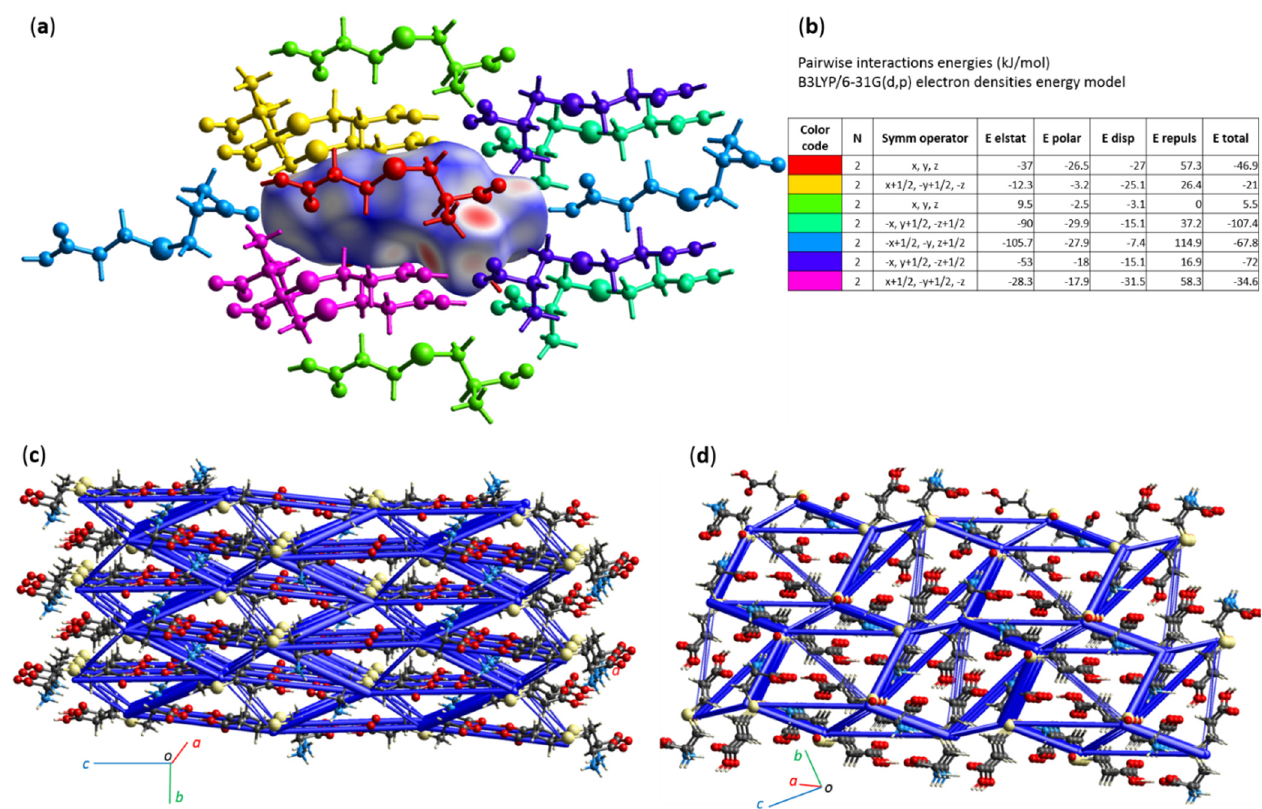
Figure 3. Interaction energies in crystal structures. ( a ) A view of interactions between a central molecule of β -CEC in crystalline 1 , shown as its Hirshfeld surface, and 14 molecules that share the interaction surfaces with the central molecule. ( b ) Calculated energies (electrostatic, polarization, dispersion, repulsion, and total) of pairwise interactions in 1 between the central molecule and those indicated by respective colors. ( c ) Energy framework for total pairwise interaction energies in 1 . The cylinders link molecular centroids, and the cylinder thickness is proportional to the magnitude of the energies, such as those shown in ( b ). For clarity, the cylinders corresponding to energies < 5 kJ mol − 1 are not shown. ( d ) The total pairwise interaction energy framework in 2 . For interaction energies in 2 and 3 , also see Supplementary Materials Figures S5 and S6. For energy frameworks depicting electrostatic and dispersion energies in crystals of 1 , 2 , and 3 ,